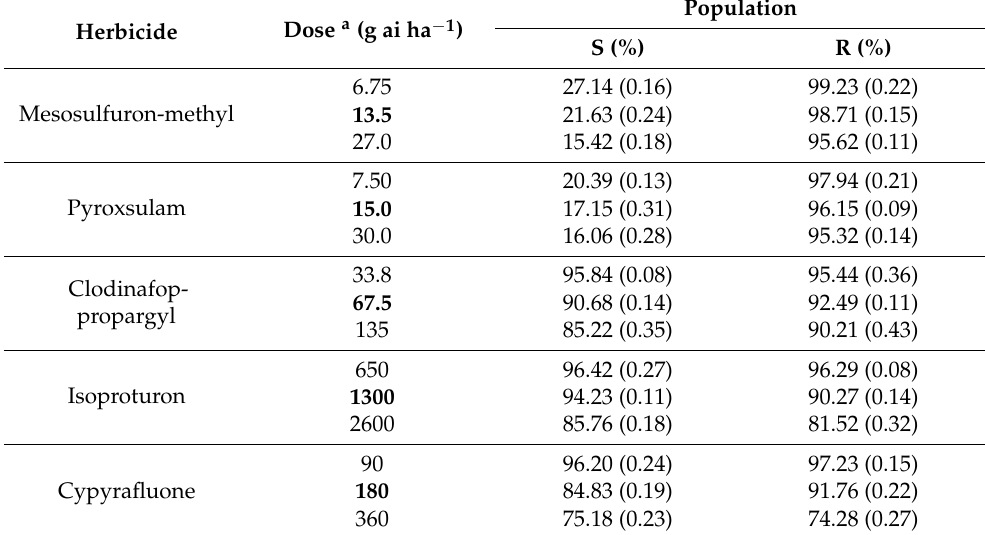
Table 2. Survival rates after cross- and multiple-herbicide resistance